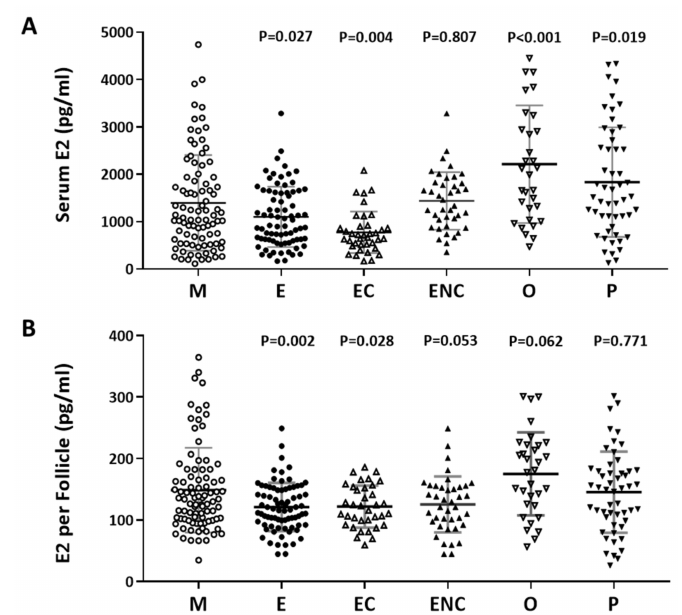
Figure 3. The relationship between serum estradiol (E2) and cycle follicle outcomes in the various infertile groups. ( A ) Serum from each infertile group was collected, and serum E2 (pg / mL) was analyzed by radioimmunoassay (RIA). ( B ) Serum E2 per follicle in each group was compared. The E2 content in the serum before removing the eggs was divided by the number of follicles. The p -value for each group versus the male factor group was determined by an unpaired t -test.